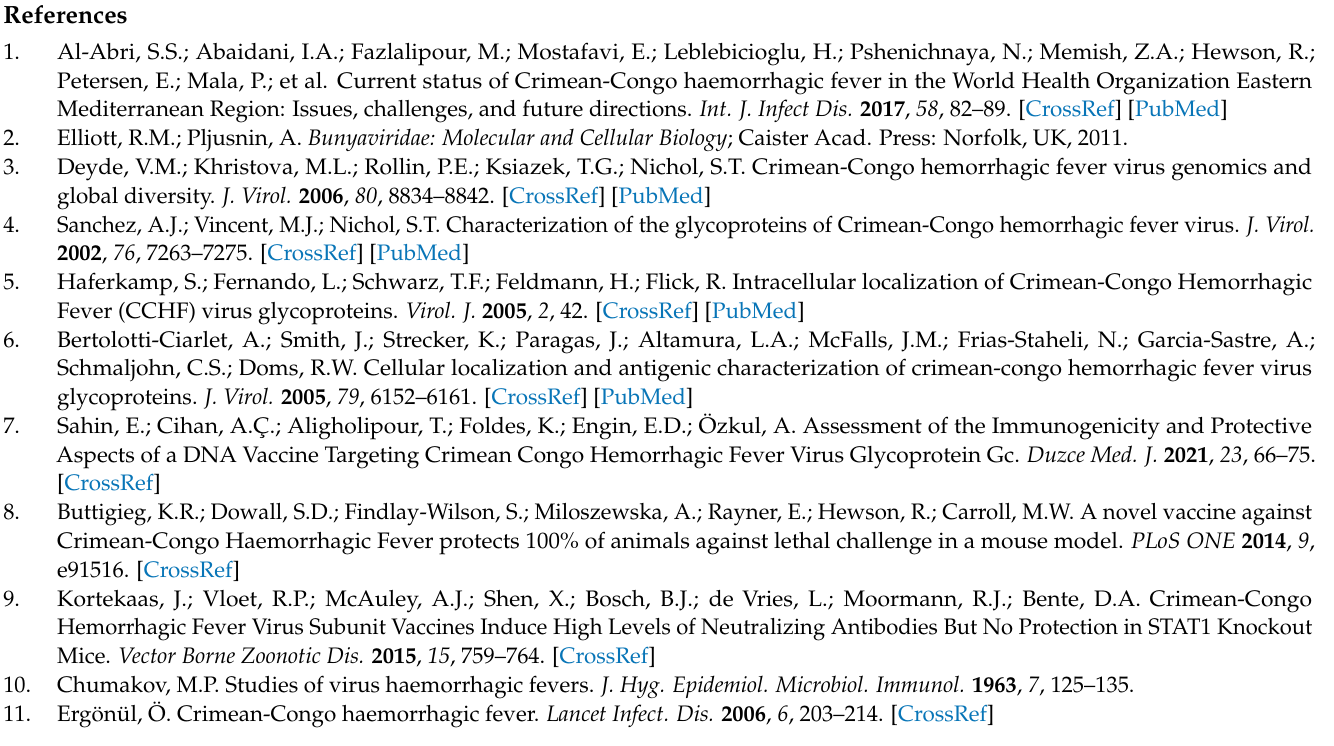
Table S6: Atom–atom interactions across TLR2-designed vaccine construct interface obtained using PDBsum server; Table S7: Atom–atom interactions across TLR3-designed vaccine construct interface obtained using PDBsum server; Table S8: Atom–atom interactions across TLR4–designed vaccine construct interface obtained using PDBsum server; Table S9: Fraction of hydrogen bonds at the designed vaccine construct–TLRs interface during the 100 ns simulation timescale (with